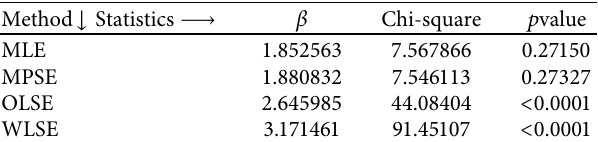
Table 19: Diferent estimators with Chi-square and its p values for data set III.